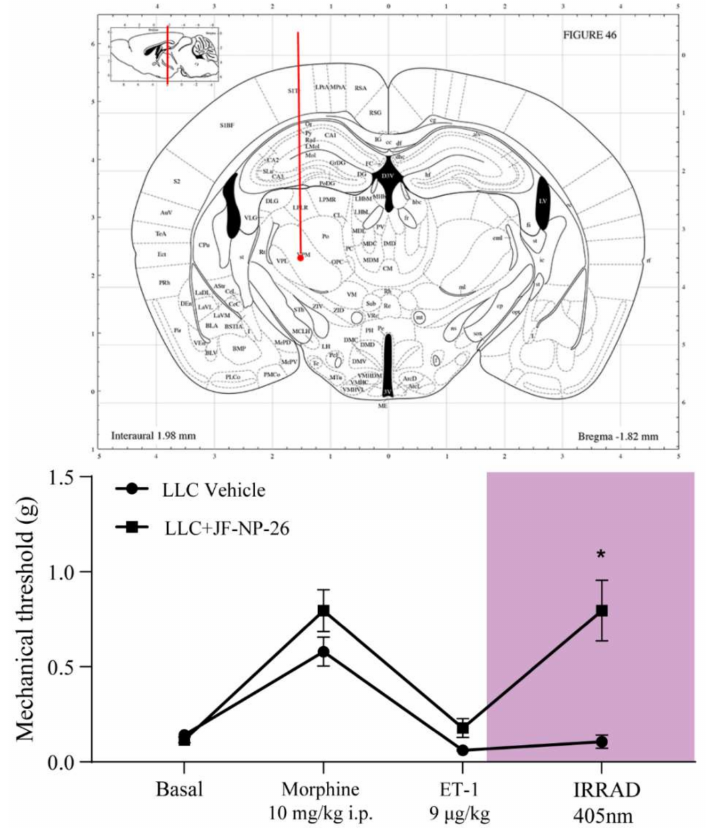
Figure 3. Light-induced activation of JF-NP-26 in the ventrobasal thalamus causes rapid analgesia in BTcP mice. Paw withdrawal thresholds were recorded 10 min before i.p. injection of morphine (10 mg/kg), 20 min after morphine injection, 5 min after intrafemoral injection of ET-1 (9 µ g/kg), and 5 min after bilateral light delivery (“IRRAD”). Values are means ± S.E.M. of 10 mice per group. Two-way ANOVA for repeated measures: Vehicle vs. JF-NP-26, F (1, 18) = 11.91; p = 0.0028; treatment, F (2.031, 36.55) = 34.11; p < 0.0001; interaction, F (3, 54) = 10.88; * p < 0.0001. Sidak’s post hoc test, p < 0.05 vs. the corresponding value of vehicle treated